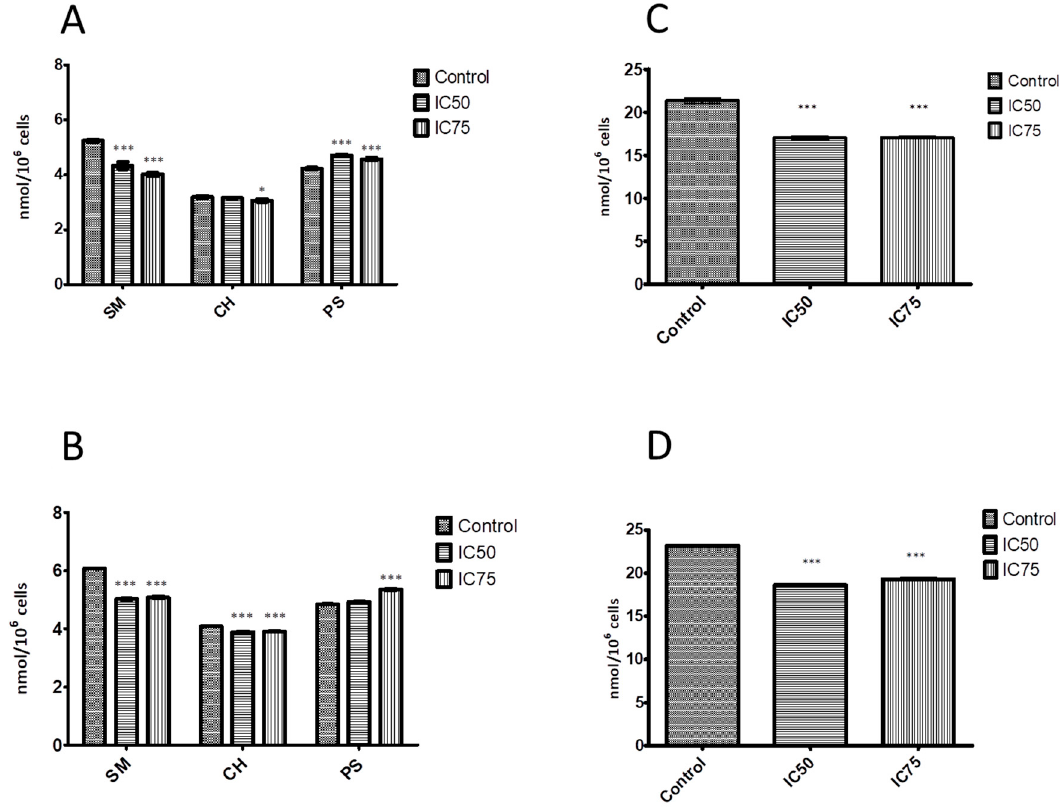
Figure 2. Effect of EPC3 on the level of sphingomyelin, cholesterol, phosphatidylserine, and phosphatidylcholine in cell membranes. ( A ) Amounts of sphingomyelin (SM), cholesterol (CH), and phosphatidylserine (PS) in MCF-7 cells treated with EPC3 for 24 h; ( B ) Amounts of sphingomyelin (SM), cholesterol (CH), phosphatidylserine (PS) in MDA-MB-231 cells treated with EPC3 for 24 h; ( C ) Amounts of phosphatidylcholine (PC) in MCF-7 cells treated with EPC3 for 24 h; ( D ) Amounts of phosphatidylcholine (PC) in MDA-MB-231 cells treated with EPC3 for 24 h. Data are obtained as means of three independent experiments. Error bars represent the standard deviations. Statistical significance is calculated against controls in each group using ANOVA one-way test and Bonferroni post-test. * p < 0.01 and *** p < 0.0001.